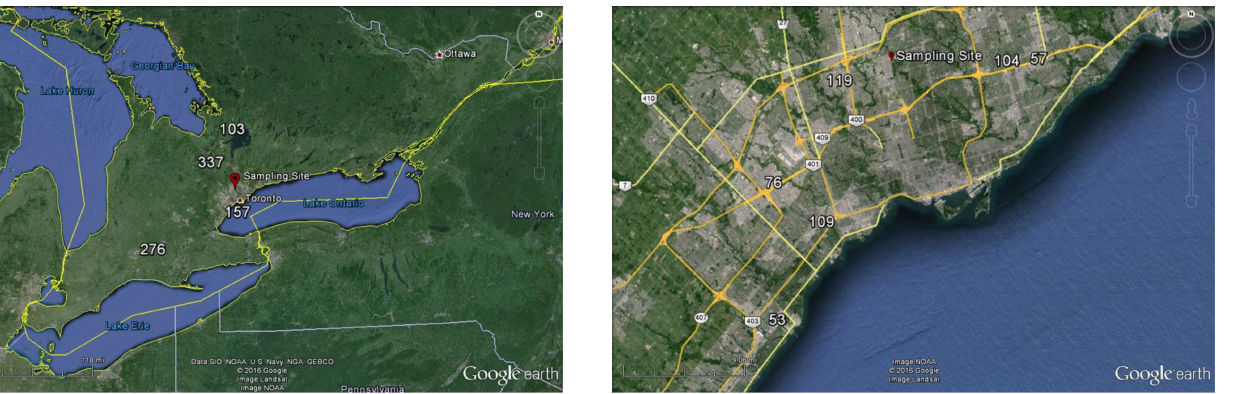
Figure 11. Location of facilities in Southern Ontario with sig- nificant emissions of xylenes. The numbers represent the annual emissions in tyear − 1 . Emission data were taken from the National Pollutant Release Inventory (NPRI). Only sources contributing at least 5% to the total emissions are shown. Also shown is the lo- cation of the sampling site. The map was produced using Google Earth ( © 2015).